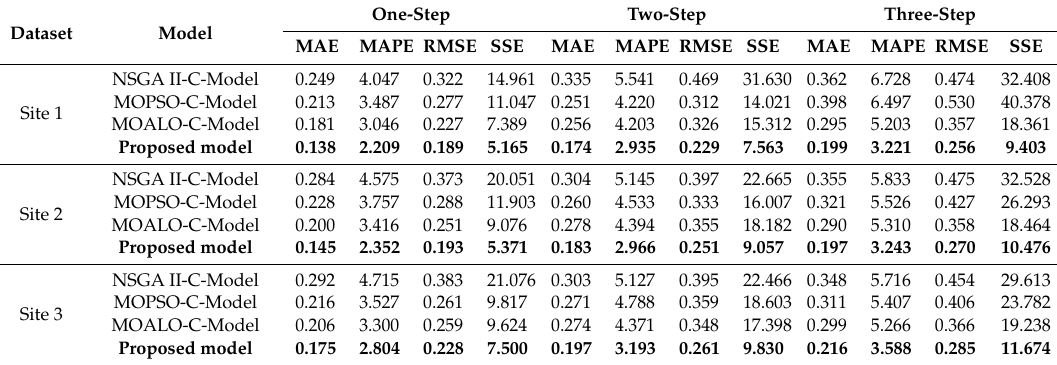
Table 13. Comparison of the evaluation metrics for the proposed strategy with models using di ff erent optimization